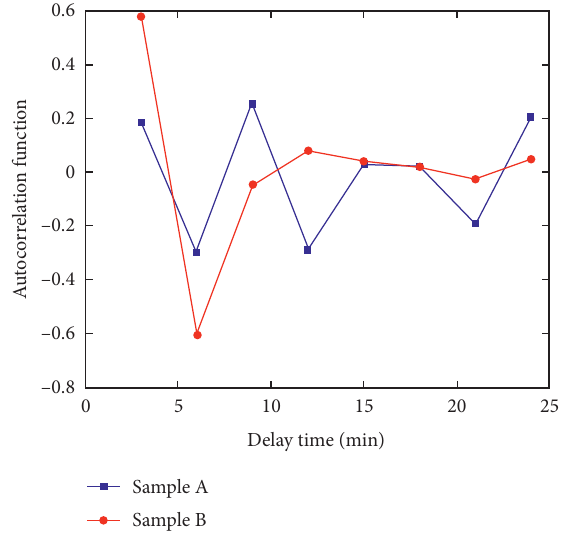
Figure 7: Calculation results of delay time of ore